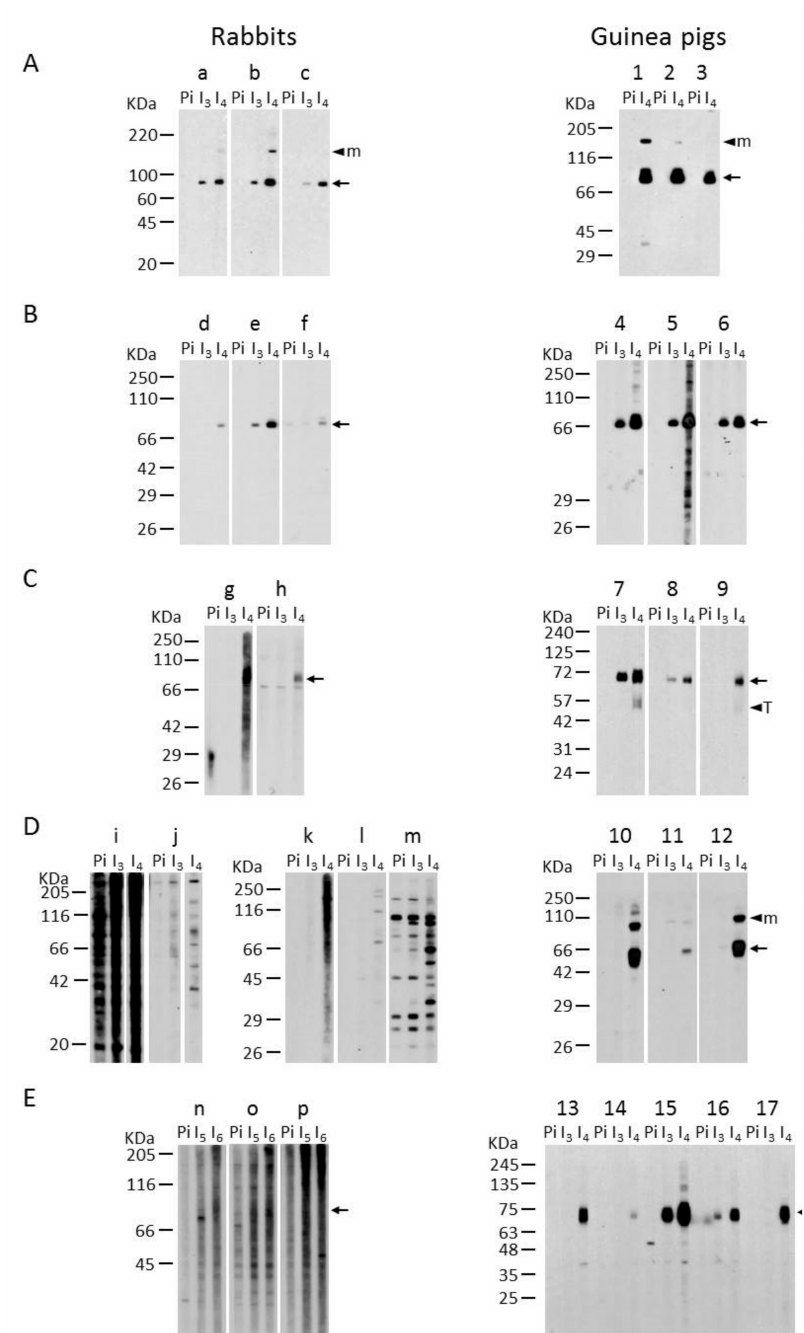
Figure 1. Immuno-blotting-based comparative analysis of rabbit and guinea pig antisera. Lysates for one large well from COS-7 cells or HEK 293T cells transfected with plasmids encoding human ecto-5 (cid:48) -nucleotidase ( A ), rat ecto-5 (cid:48) -nucleotidase ( B ), human NTPDase1 ( C ), mouse NTPDase3 ( D ) or mouse NTPDase8 ( E ) were subjected to electrophoresis under non-reducing conditions, electrotransferred to an Immobilon-P membrane and probed with rabbits “a” to “p” (left panels) or guinea pig “1” to “17” (right panels) antisera. The sera presented are the pre-immune (Pi) negative controls and the immune sera collected after the third (I 3 ), the fourth (I 4 ), the fifth (I 5 ) or the sixth (I 6 ) injection. Specific bands are denoted with an arrow. Multimeric (M) and truncated (T) protein forms are indicated with an arrow head. The antibodies shown were diluted 1:500 except for the rabbit “g” in panel C and rabbits “k,” “l” and “m” in panel D that were diluted